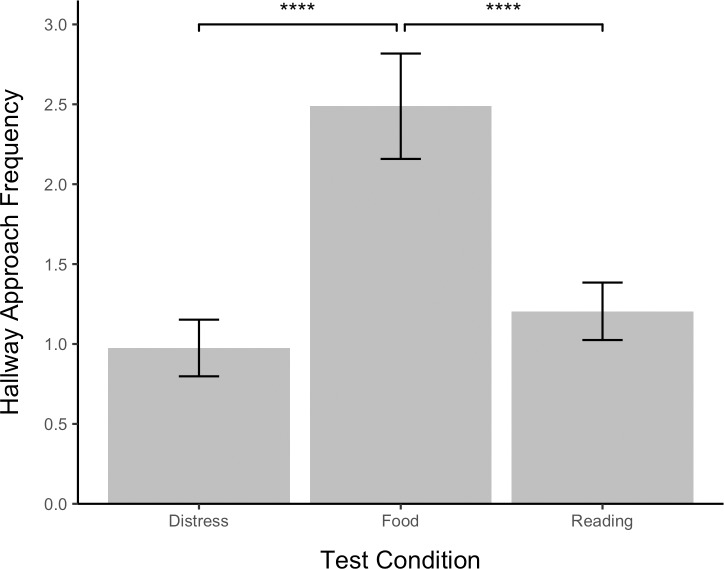
Hallway approach frequency by test condition.Error bars show standard errors.